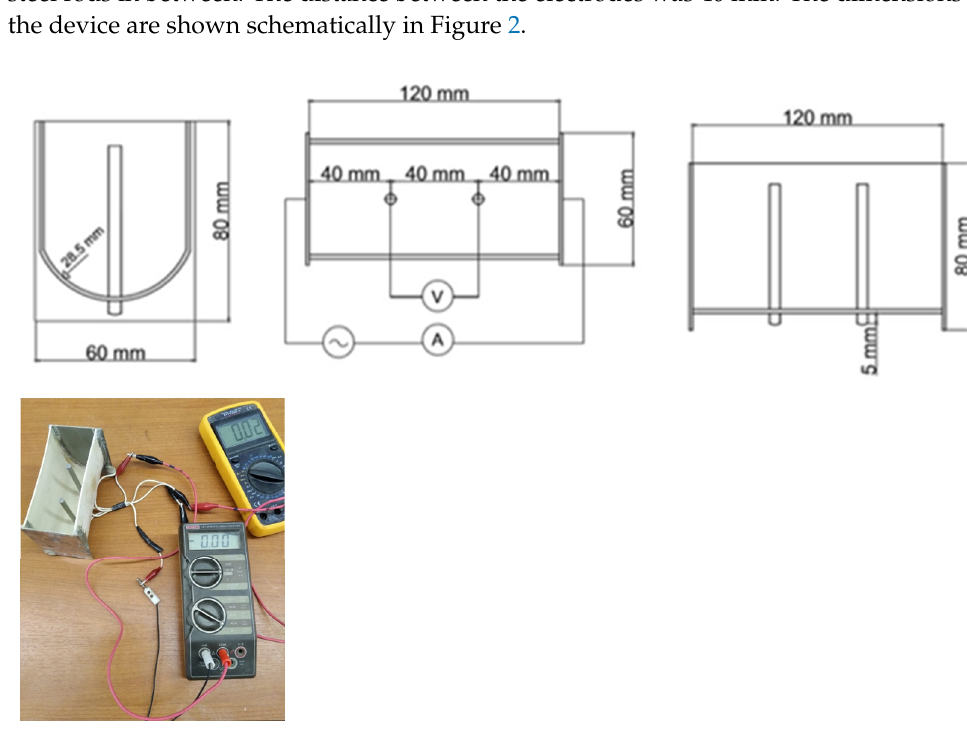
Table 1. Aggregates properties.